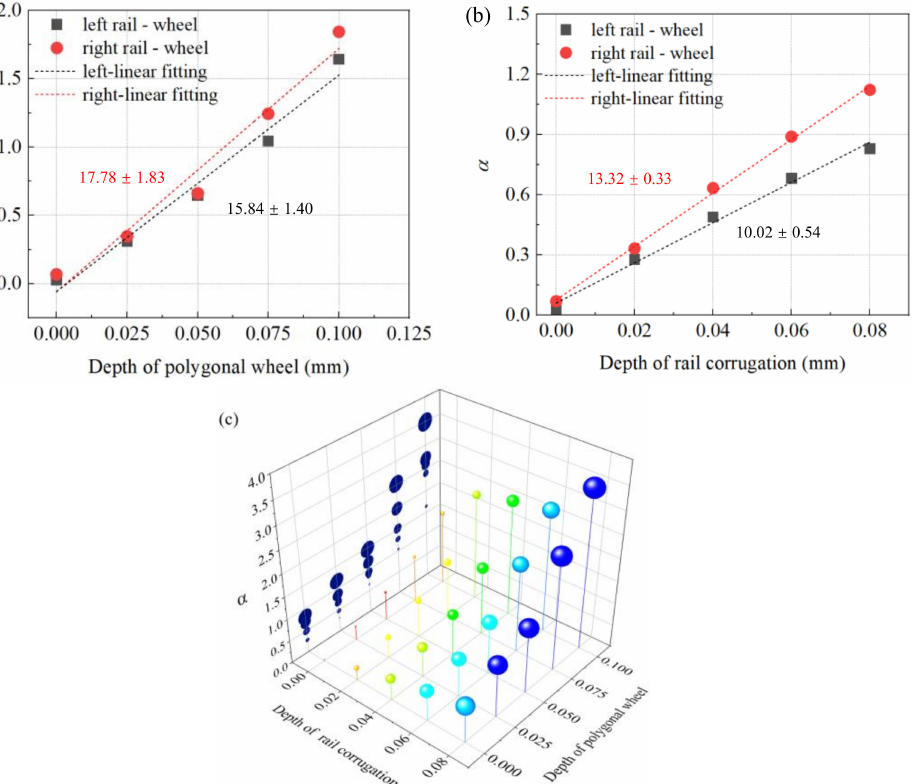
Figure 12. Effect of the depth of periodic wear on the stability of the wheel–rail system: ( a ) depth variation of polygonal wheel; ( b ) depth variation of rail corrugation; ( c ) depth variations of both wheel polygon and rail